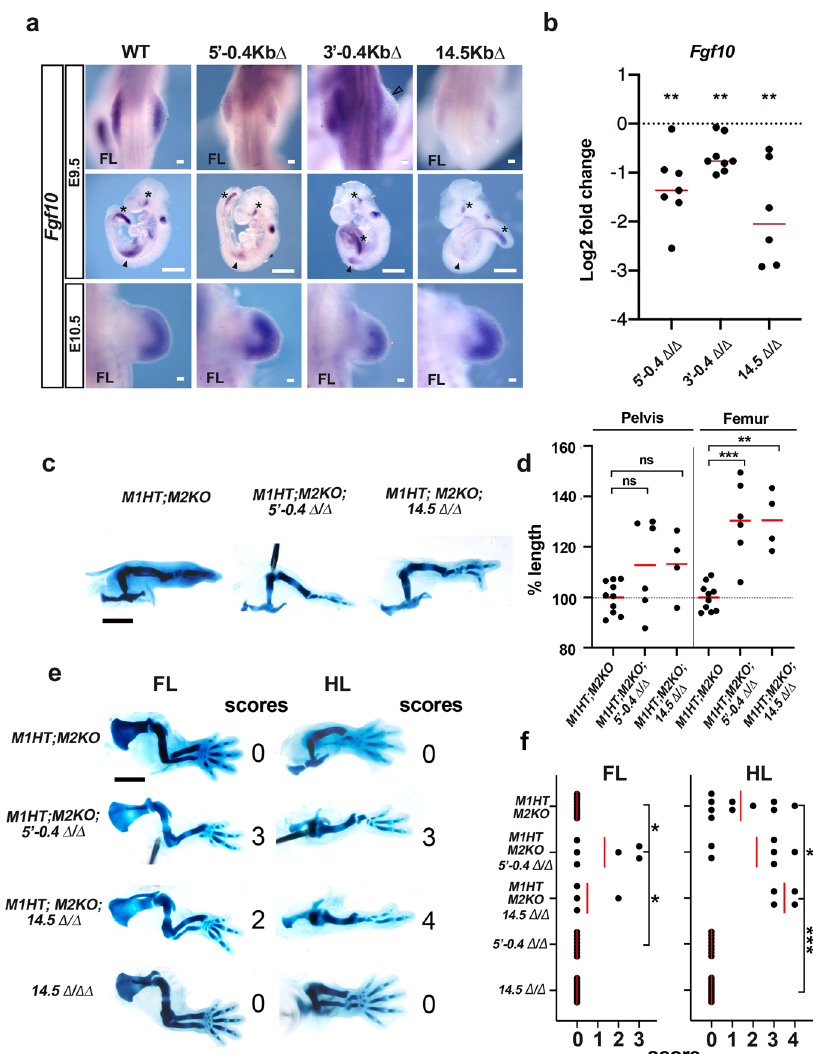
Fig. 6 Regulatory elements bound by Meis, Tbx, and Hox factors control Fgf10 expression at limb initiation. a Fgf10 expression at E9.5 and E10.5 in embryos with the CRISPR/Cas9-mediated-targeted Meis deletions indicated in c . Solid arrowheads indicate Fgf10 expression domain in FLs. Asterisks indicate non-limb Fgf10 expression domains. Empty arrowhead indicates the speci fi c absence of Fgf10 expression in the anterior limb bud. Limbs analyzed: N = 12 for 5 ′ − 0.4 Δ , N = 10 for 3 ′ − 0.4 Δ , and N = 8 for 14.5 Δ . Scale bars = 100 μ m in FLs and 1000 μ m in whole embryos. b Quantitative RT-PCR showing a reduction of Fgf10 transcripts in E9.5 FL buds of embryos with the indicated regulatory region deletions. Limbs analyzed: For 5 ′ − 0.4 Δ , N = 7; For 3 ′ − 0.4 Δ , N = 8. For 14.5 Δ , N = 6. Two-tailed, one-sample t -test. Exact p -values from left to right: 0.0037; 0.0013; 0.0081 respectively. Red bars represent median values. c Examples of limb skeletons of genetic combinations between Meis mutants and Fgf10 regulatory region deletions. Scale bar = 1000 μ m. d Comparison of pelvis and femur length in genetic combinations of Meis mutants and Fgf10 regulatory region deletions. Two-tailed, unpaired Mann – Whitney test. Limbs analyzed: M1HTM2KO N = 10; M1HTM2KO;5 ′ − 0.4 Δ , N = 6; M1HTM2KO;14.5 Δ , N = 4. Exact p -values from left to right: 0.3132; 0.0759; 0.0019; 0.0020. Red bars represent mean values. e Examples of limb skeletons of genetic combinations between Meis mutants and Fgf10 regulatory region deletions, showing the limb AP axis. Scale bar = 1000 μ m. f Scoring of skeletal element loss in the genetic combinations of Meis mutants and Fgf10 regulatory region deletions shown in c . Loss of each skeletal element ( fi bula or digit) scores 1. Embryos analyzed: M1HTM2KO N = 10; M1HTM2KO;5 ′ − 0.4 Δ , N = 6; M1HTM2KO;14.5 Δ , N = 4; 14.5 Δ N = 12; 5 ′ − 0.4 Δ , N = 8. Two-tailed, unpaired Mann – Whitney test. Exact p -values from top to down and left to right: 0.0357; 0.0245; 0.0360; 0.0005. Red bars represent mean values. ns, non-signi fi cant; * p < 0.05, ** p < 0.01, *** p < 0.001. Statistics were not adjusted for multiple comparisons. Source data are provided as a Source Data fi le. Source images are available at Mendeley Data